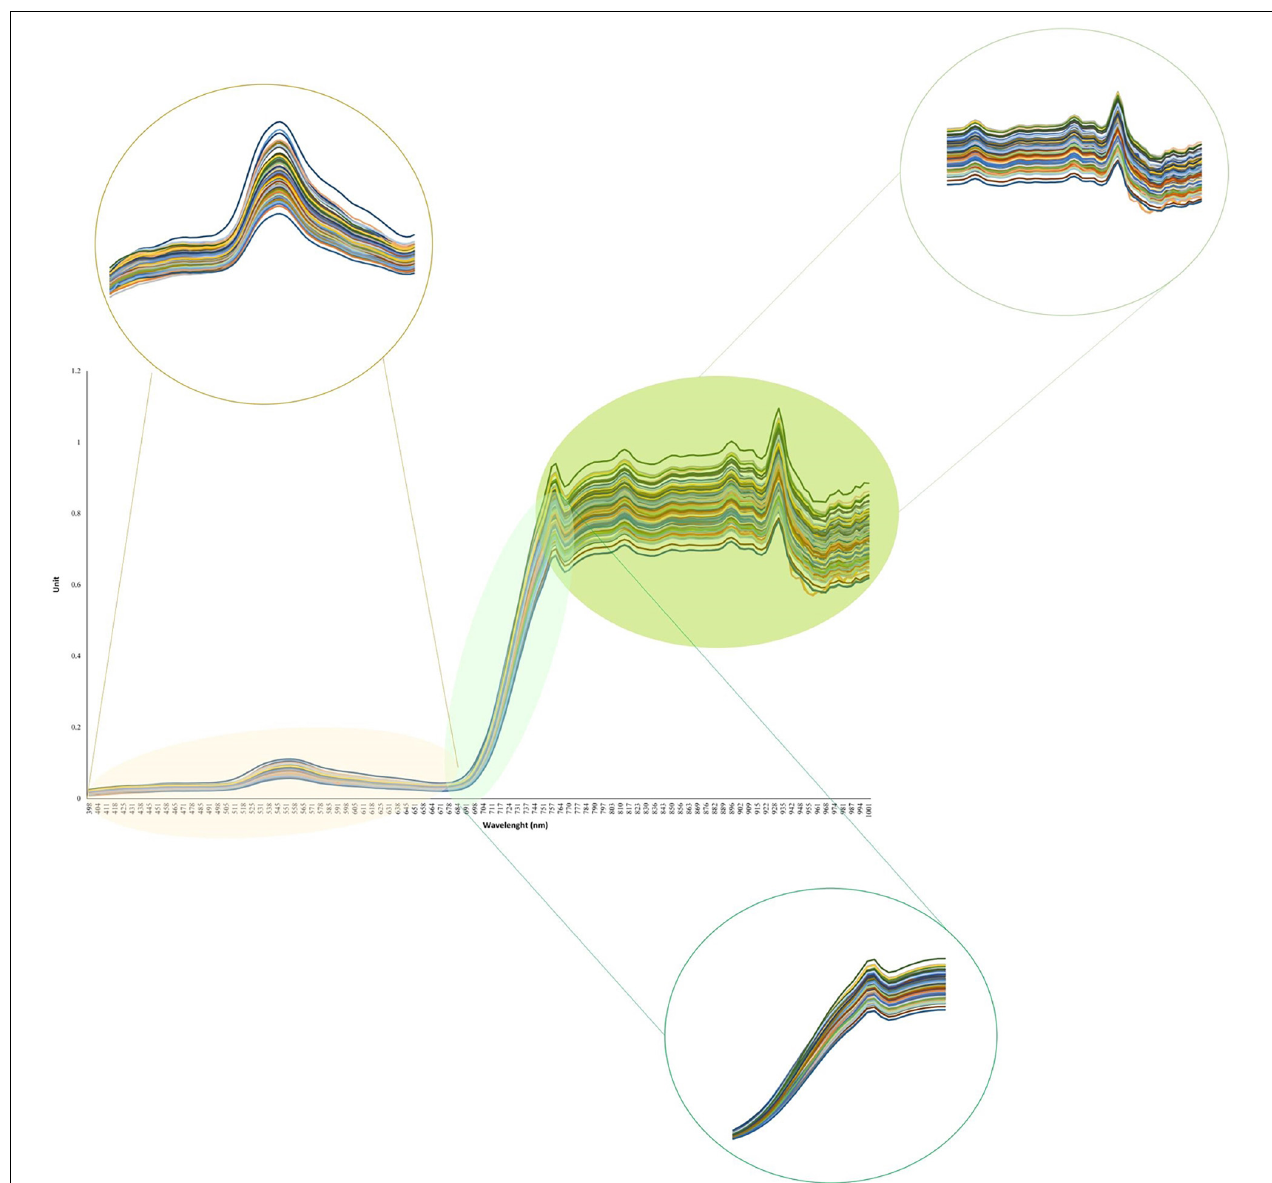
FIGURE 3 | The hyperspectral reflectance profile of the tested 227 soybean